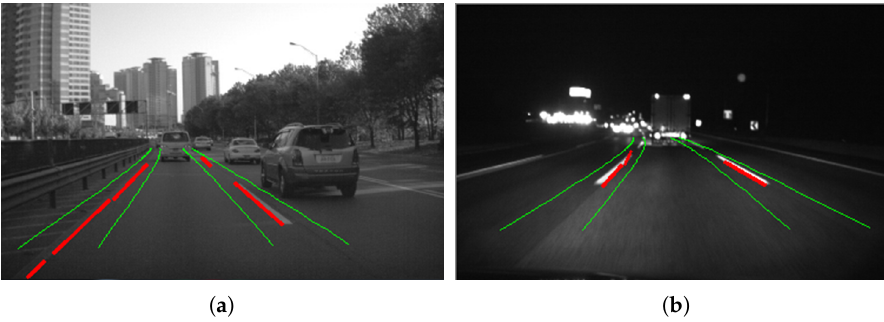
Figure 4. Line detection and lane tracking results: ( a ) daytime result, and ( b ) night result.